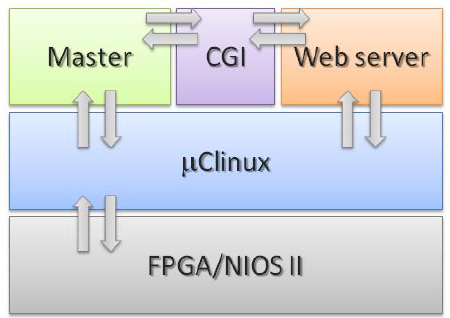
Figure 5. Architecture of the implemented